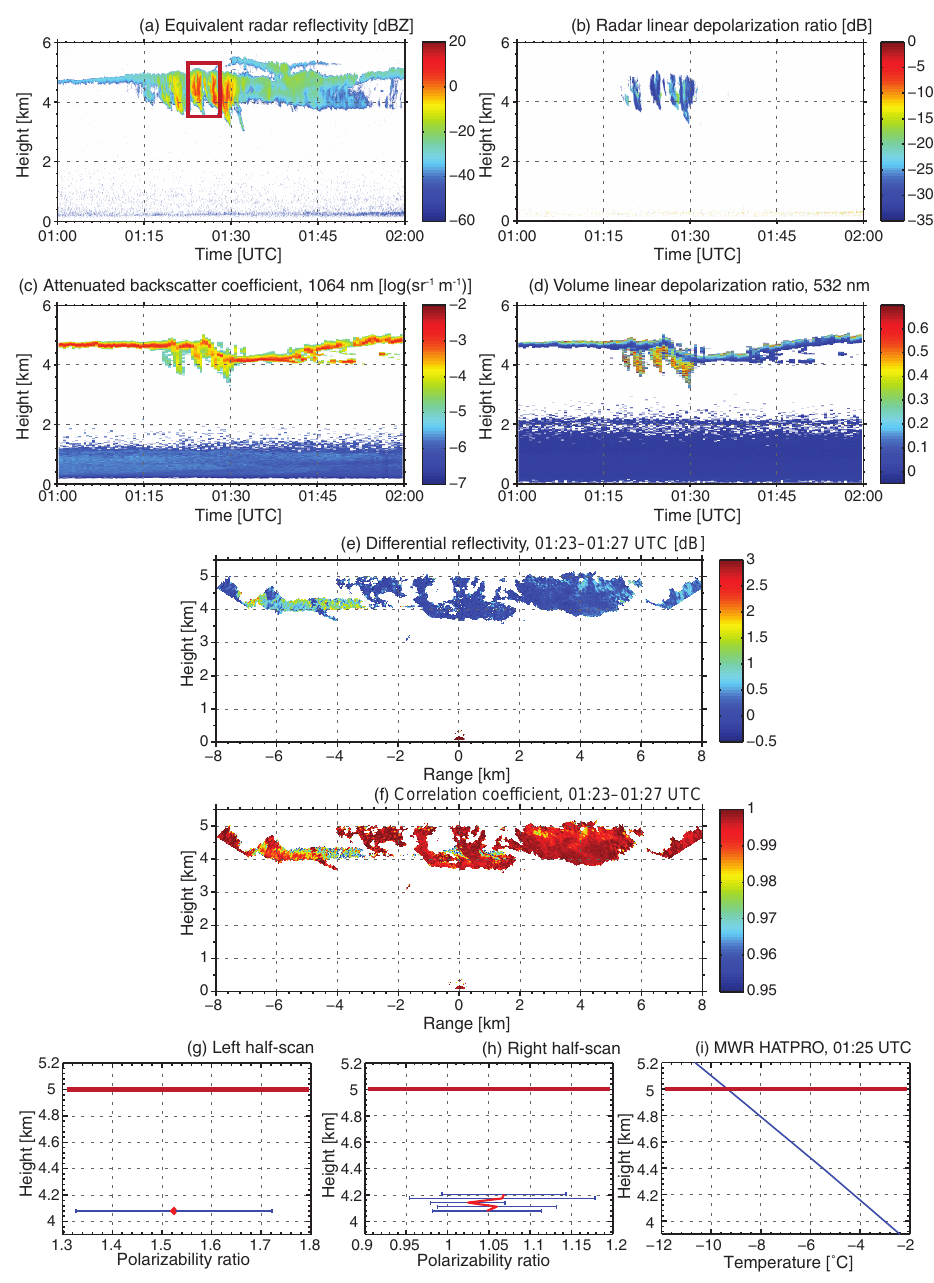
Figure 4. Same as in Fig. 3 but for 18 October 2014 and without a photograph.